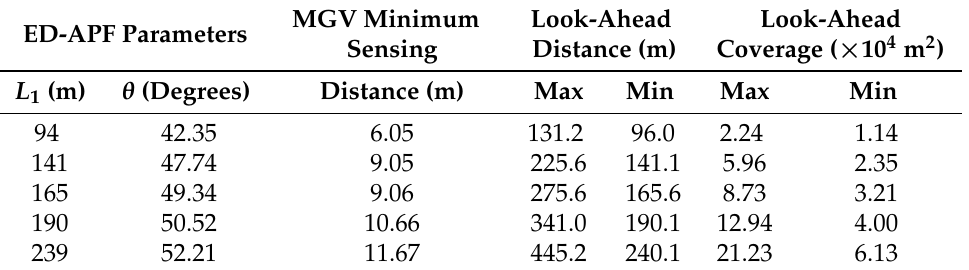
Table 1. The ED-APF’s look-ahead distance and coverage for different L 1 values at the MGV’s velocity of 4